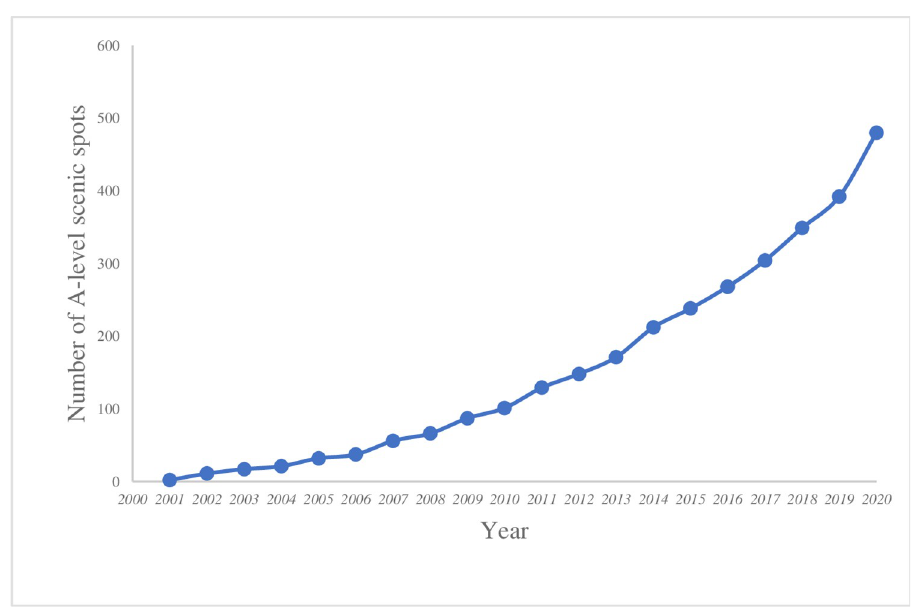
Fig 1. Transformation in the number of A-level scenic spots in Guangdong Province from 2001 to